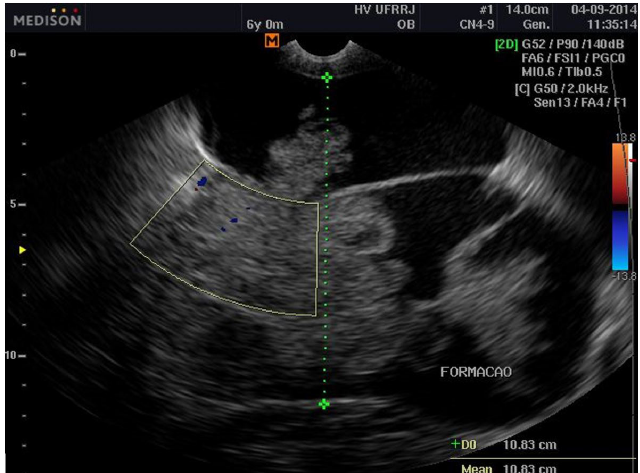
Figure 1. Cystic and vascular formation in the right